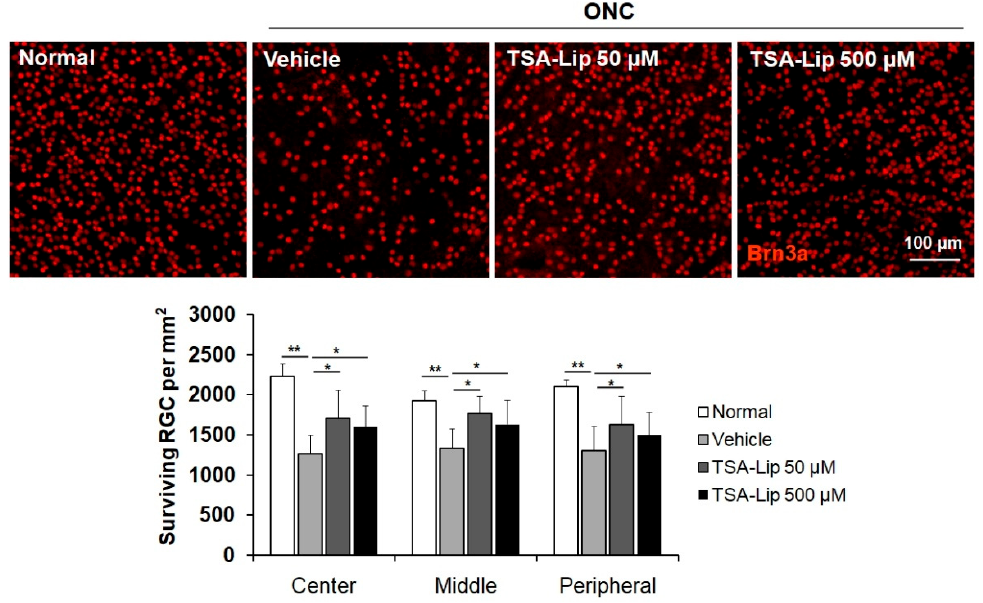
Figure 8. Effect of TSA-loaded liposomes on RGC survival after ONC. Retinal flat mounts are shown for the uninjured normal retinas, vehicle-injected retinas, and retinas injected with 50 μ M and 500 μ M TSA-loaded liposomes ( n = 5 retinas per group). A quantitative analysis of RGC survival in center, middle, and peripheral zones of each retinal quadrant is also shown as a graph. TSA - Lip 50 μ M = liposomes loaded with 50 μ M TSA; TSA - Lip 500 μ M = liposomes loaded with 500 μ M TSA. Scale bar = 100 μ m; ** p < 0.001, compared to the uninjured normal retina; * p < 0.05 compared to the vehicle-injected retina; one-way ANOVA with post-hoc LSD test.